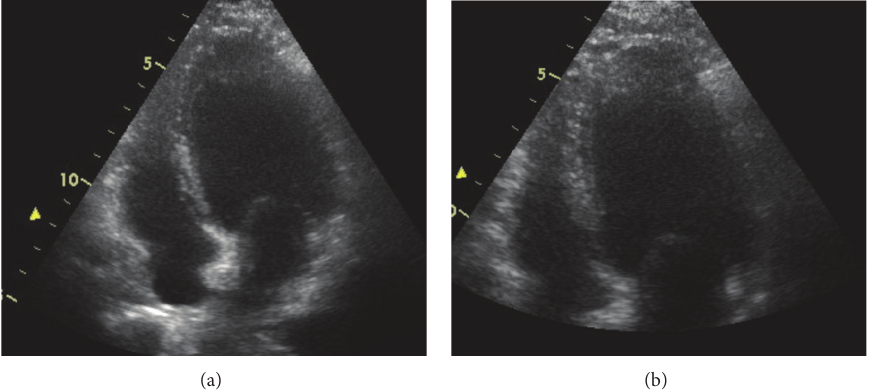
Figure 2: Echocardiogram showed a severely dilated left ventricular apex with associated thrombus.